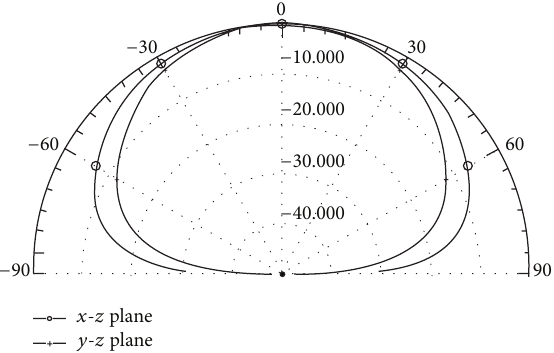
Figure 7: Element pattern of designed reflectarray element.